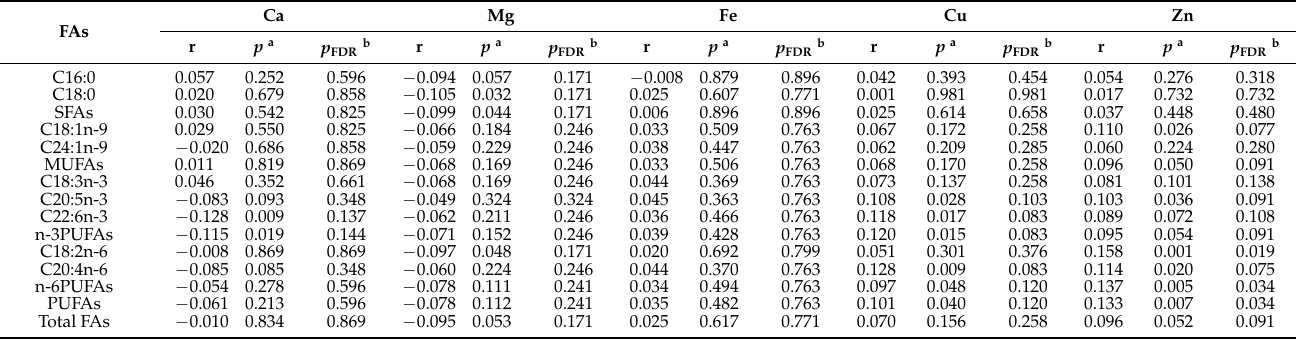
Table 3. Partial correlation analysis of mineral elements with erythrocyte FAs in children.